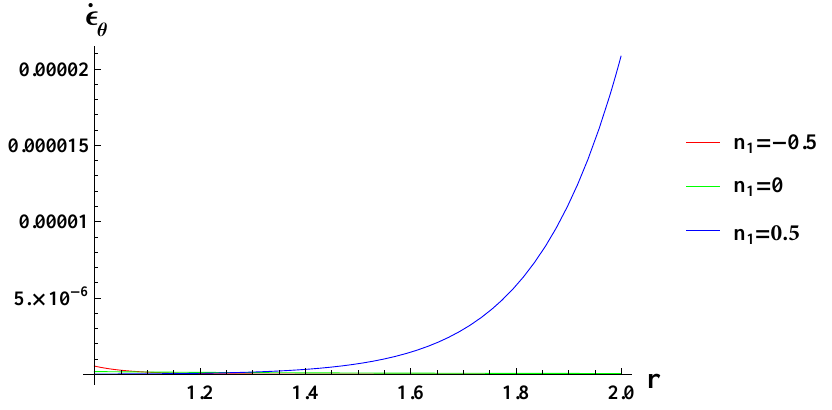
Figure 10. Tangential strain rate along the radius r (in cm) of the cylinder, under the effect of rotation ( ω 2 = 50 rad/s), external pressure p o = 50 MPa and exponential volume reinforcement.